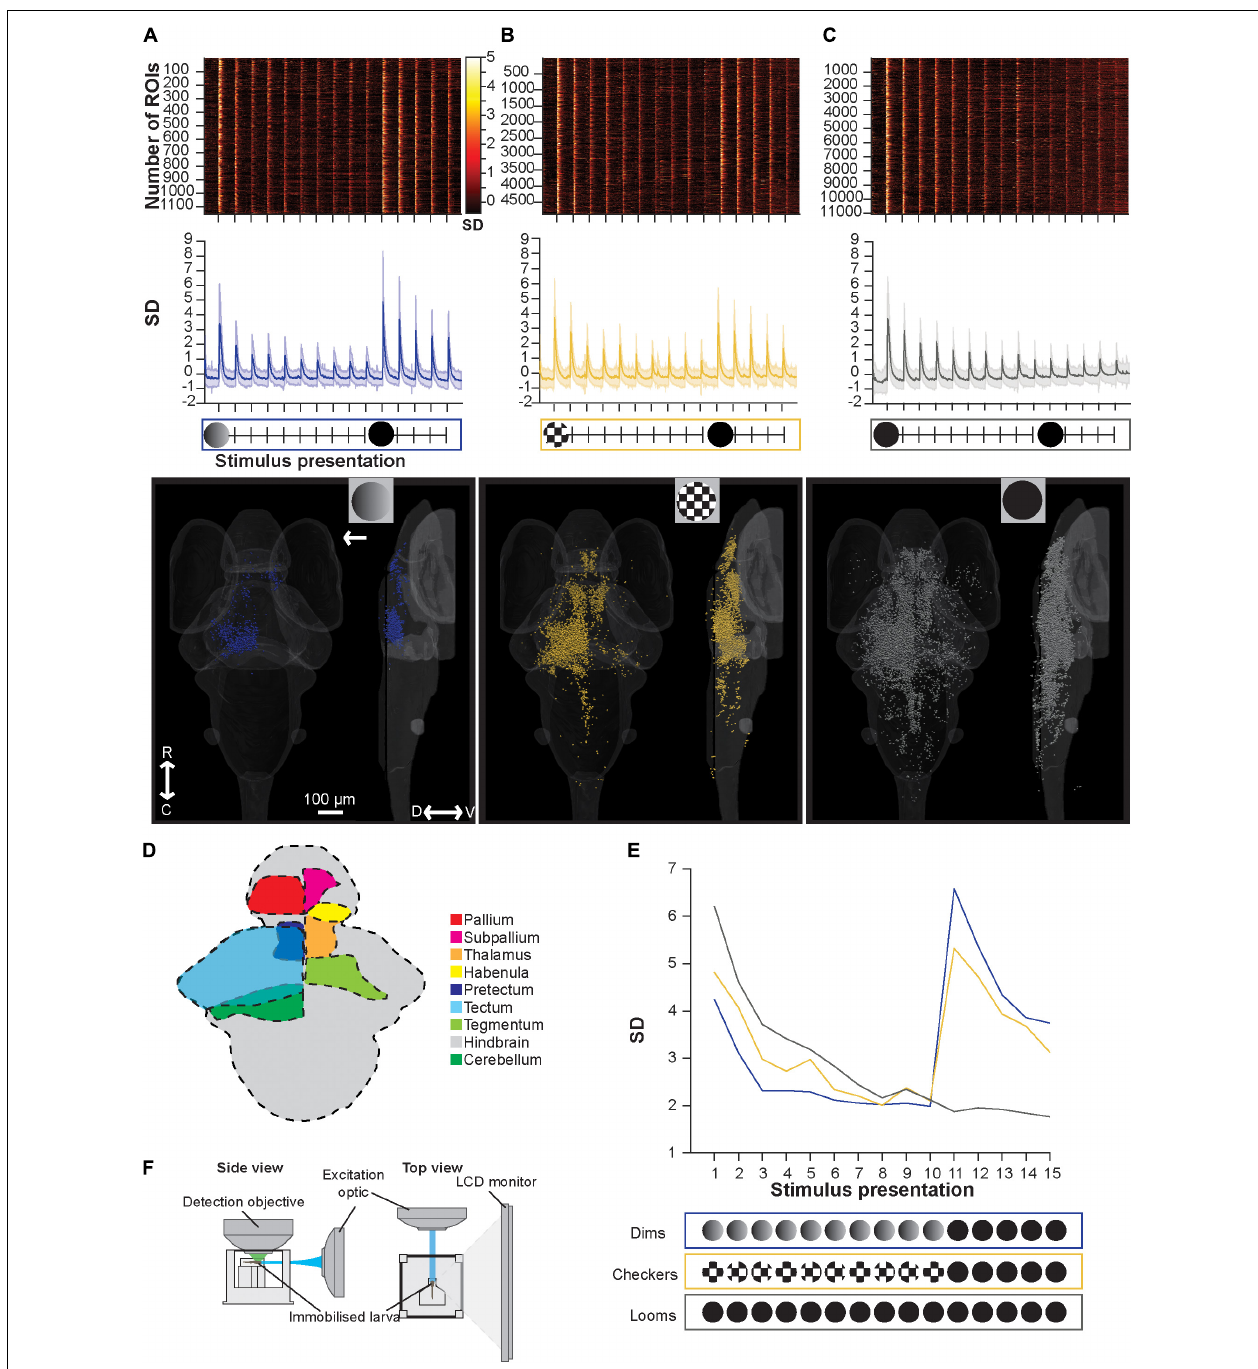
FIGURE 2 | Brain-wide calcium responses to repeated loom, checkerboard, and dim stimuli. (A) A raster plot (top), average trace with S.D. shaded (middle), and transverse and lateral spatial distributions (bottom) of dim sensitive ROIs, arrow represents position of stimulus presentation. (B) Shows the same information for ROIs sensitive to checkerboards, and panel (C) shows this information for ROIs responsive to looms. (D) Schematic representation of key regions’ locations in the larval zebrafish brain. (E) The average maximum brain-wide response of dim, checkerboard, and loom sensitive ROIs and the stimulus trains used during these calcium imaging experiments. Habituation was significant ( p = 3.42E-18) for loom sensitive ROIs, checkerboard sensitive ROIs ( p = 1.91E-8) and dim sensitive ROIs ( p = 2.43E-4, tested with the nparLD R package, using Bonferroni correction for multiple comparisons, adjusting the p -value for significance to 0.01). Responses to the first loom (11th stimulus) were not significantly different from naive loom responses for animals shown checkerboards ( p = 0.1513) or dims ( p = 0.4491, tested with a Mann–Whitney U test, using Bonferroni correction for multiple comparisons, adjusting the p -value for significance to 0.01). (F) Experimental set up used for calcium imaging experiments, where larval zebrafish are presented the stimulus train on an LED monitor. R, rostral; C, caudal; D, dorsal; V, ventral.